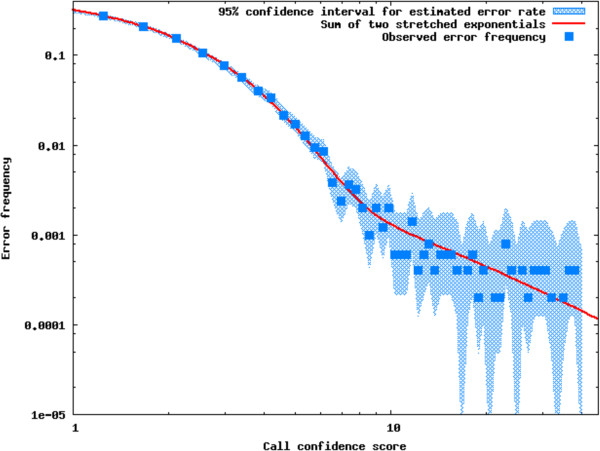
Genotype call error rate as a function of call confidence score for bins of 10,000 calls in simulated Ciona intestinalis genome data. The stippled blue region shows 95% confidence intervals of the Bayesian posterior probability distribution of the underlying error rate computed from the Beta distribution Beta(ne + 1, nc − ne + 1) conjugate the assumed binomial distribution of observed errors, where ne and nc are the number of errors and number of calls in each bin respectively. The red curve shows the best fit error model a1e−sc1b1+a2e−sc2b2, with parameter values a1 = 0.49, b1 = 2.08, c1 = 1.26, a2 = 5.47, b2 = 0.17, c2 = 0.16. χ2 reduced = 0.82.